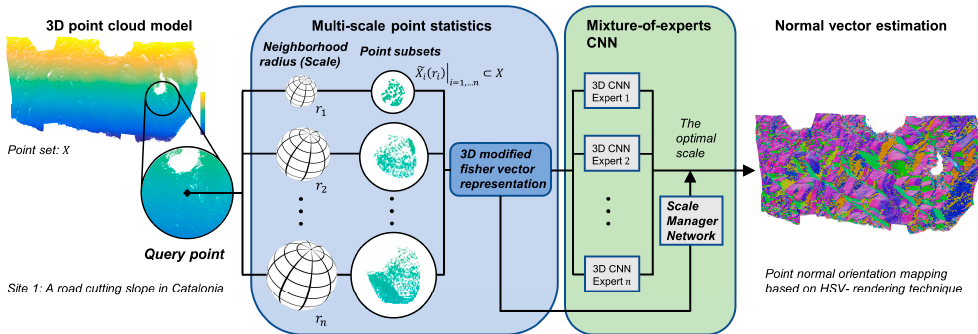
Figure 5. Scheme of normal vector estimation based on Nesti-Net algorithm updated from Ben-Shabat et al. [53]. The multi-scale point statistics for each point from a given PCM is computed. Then, the optimal scale is determined by a scale manager network. The normal vectors are calculated by mixture-of-experts CNN, and mapped by a HSV-rendering technique (Liu and Kaufmann [55]).